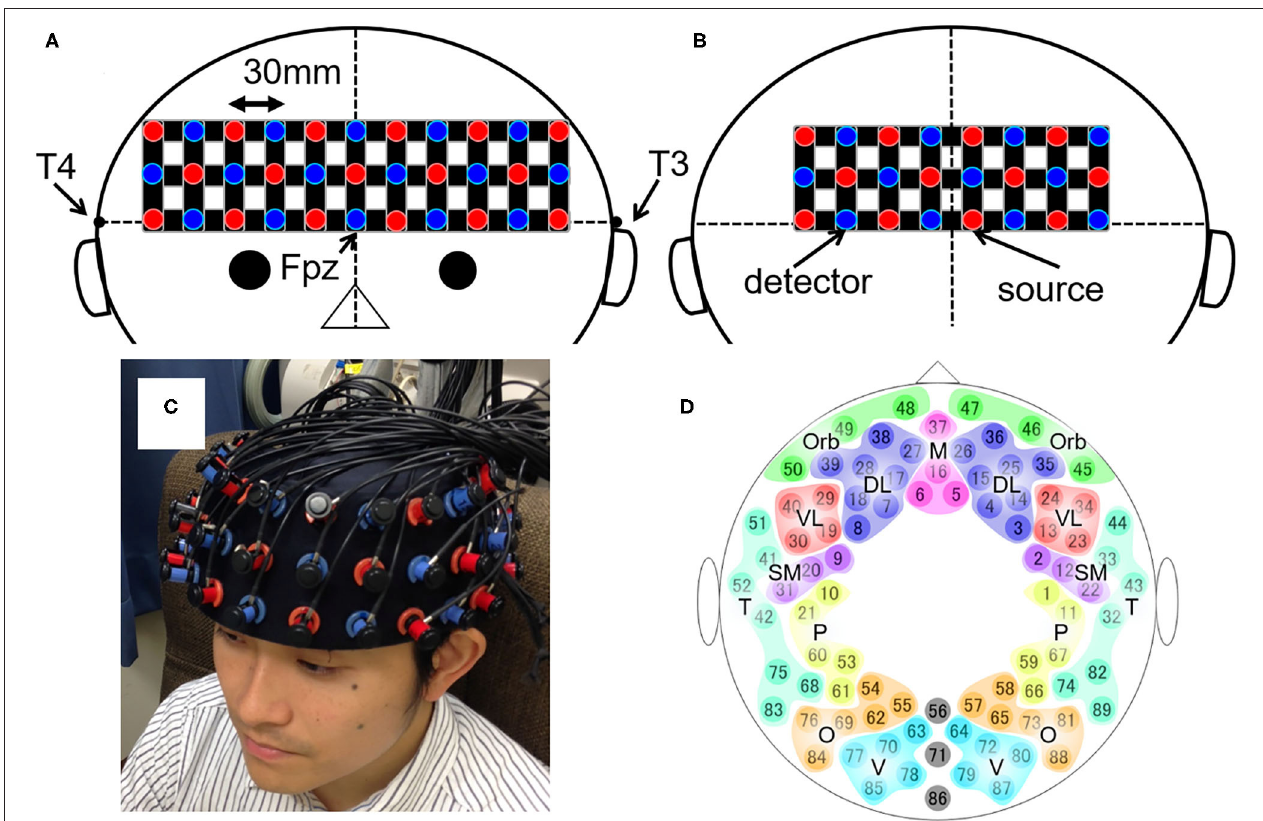
FIGURE 1 | The layout of the whole-head NIRS system and the 89 measuring points. (A,B) Schematic illustration of (A) the anterior and (B) the posterior shells of the whole-head NIRS arrangement. The red and blue circles depict the source and detector probes, respectively. The black horizontal line represents the planar surface defined by T3, Fpz, and T4 according to the international 10–20 system for electroencephalography. The black vertical line represents the midline. (C) The actual placement of the probes on the head. (D) Schematic illustration of the 89 measuring points and their categorization into 17 brain regions. DL, dorsolateral prefrontal cortex; M, medial prefrontal cortex; Orb, orbitofrontal cortex; VL, ventrolateral prefrontal cortex; SM, sensorimotor area; P, parietal lobe; T, temporal lobe; O, occipital lobe; V, visual area.